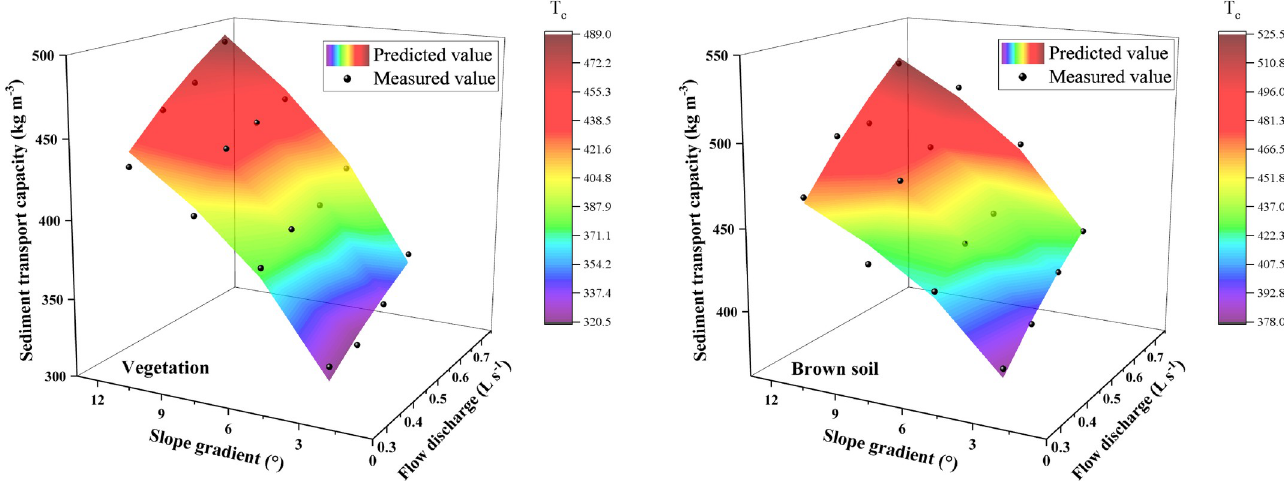
Fig 5. The measured values were distributed in the best predicted range.